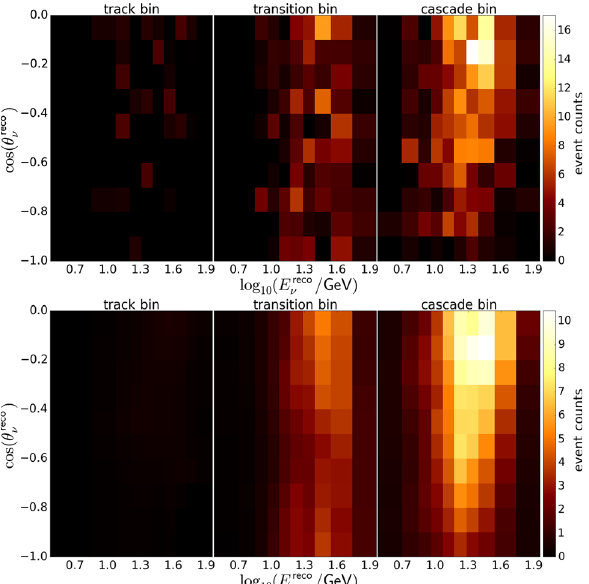
Fig. 5 Top: the distribution in PID, zenith angle, and neutrino energy for Analysis A that enters the likelihood calculation; bottom: corre- sponding signature of the NMO, given as expected pull on the bin con- tent in case IO is observed but NO is tested, using Poissonian